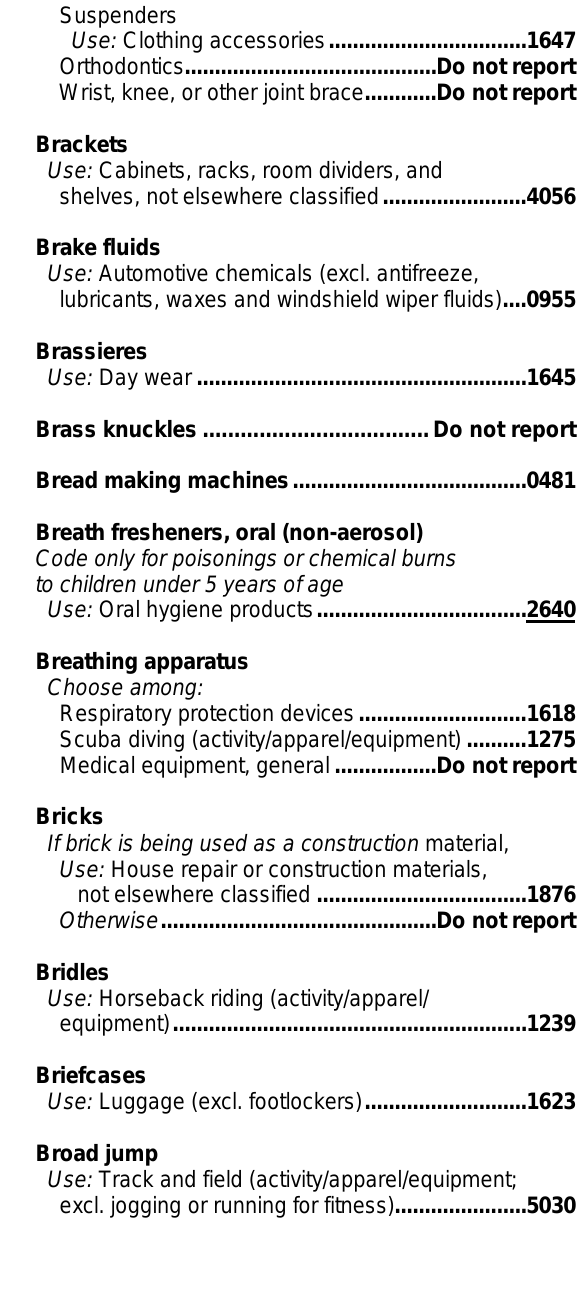
Tableware and accessories Bows and arrows Choose among: